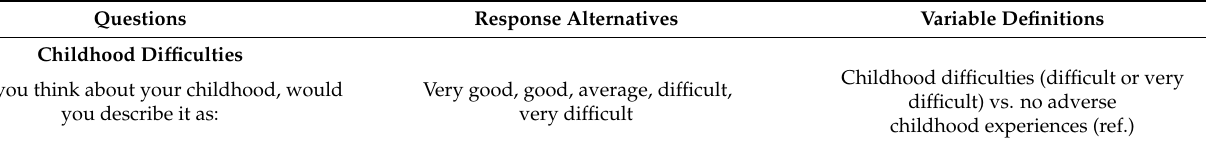
Table 1. Questions, response alternatives, and variable